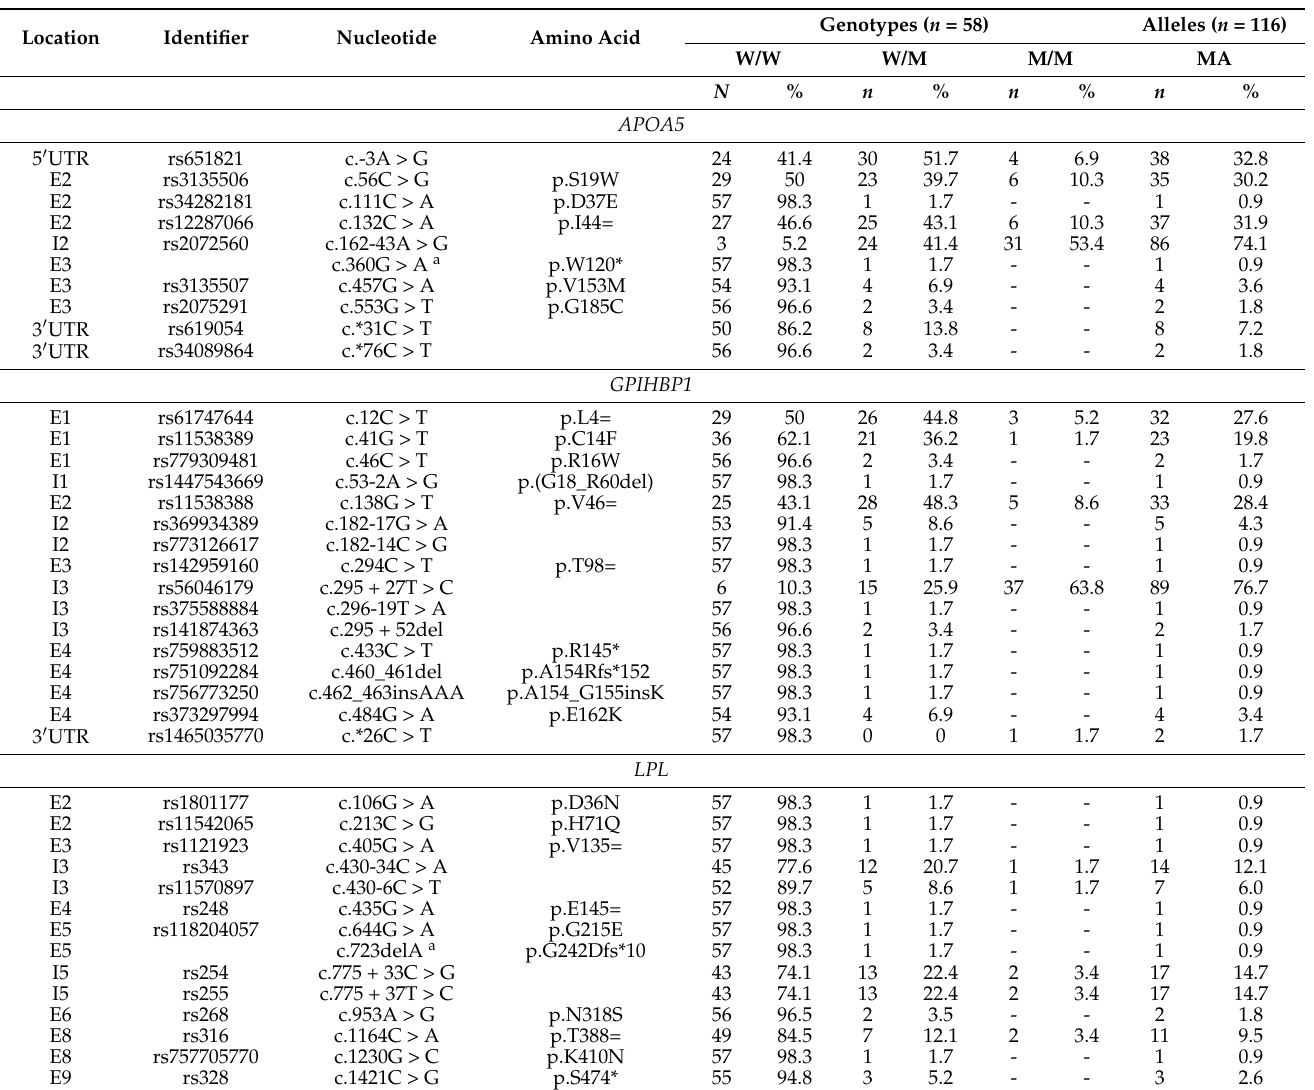
Table 2. Genotypic and allelic frequencies of the APOA5, GPIHBP1, and LPL genes variants detected in patients with primary